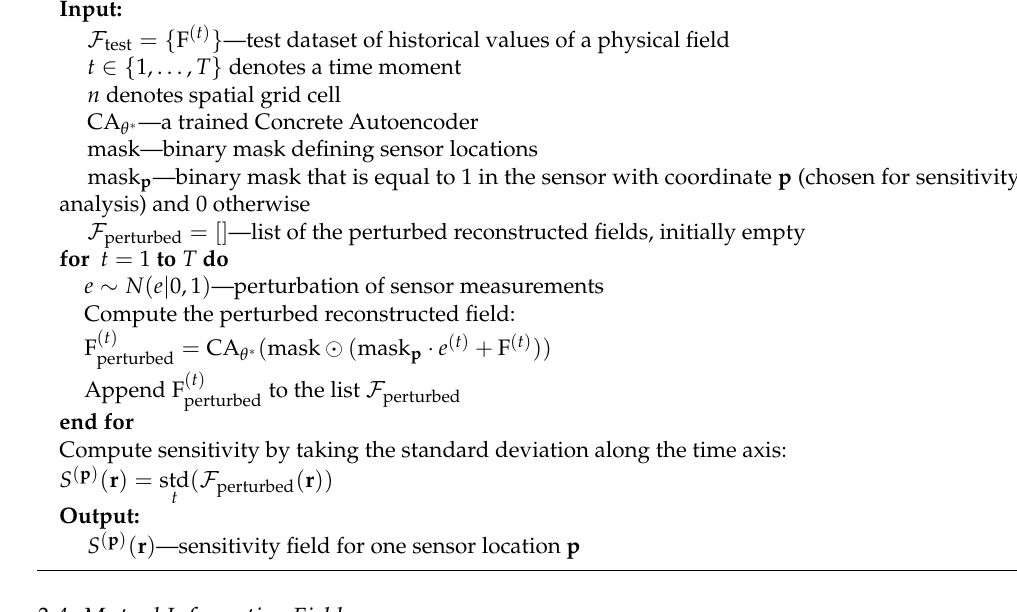
Algorithm 3 Sensitivity field computation from a trained Concrete Autoencoder.